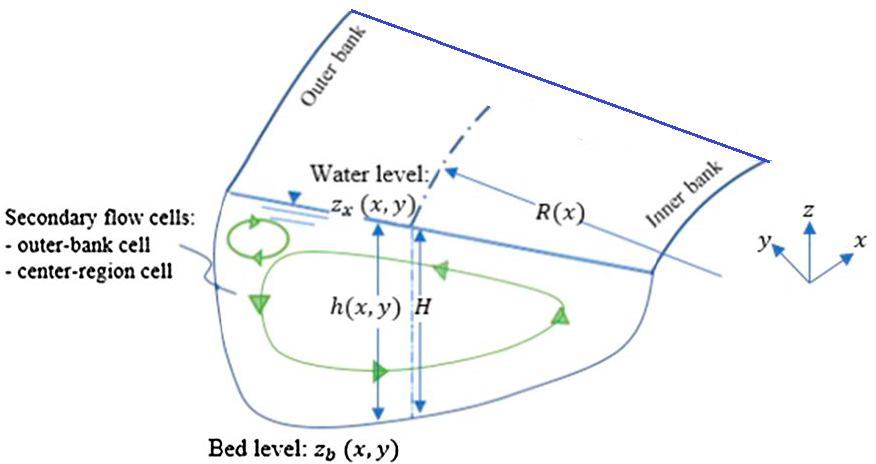
Figure 3 . Secondary flow cells (based on Blanckaert (2011) [31] . Figure 3. Secondary flow cells (based on Blanckaert (2011)